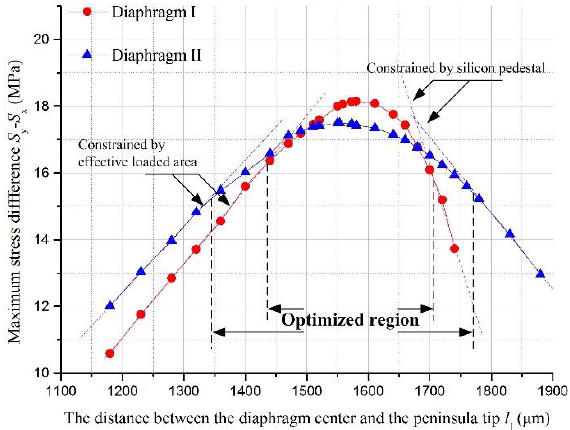
Figure 11. The relationship between maximum stress difference ( σ = S y − S x ) and l 1 for two diaphragm structures.